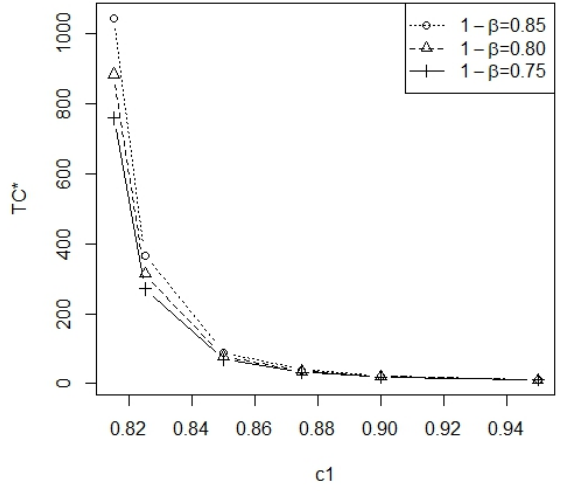
α = 0.01, 0.05, 0.1.